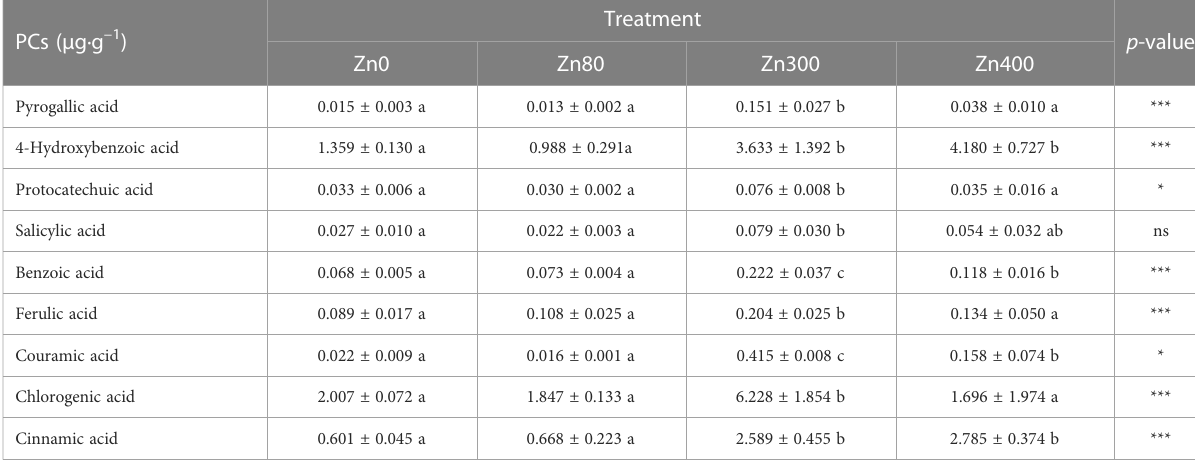
TABLE 3 Effects of ZnSO 4 treatments on phenolic compounds (PCs) in Cd-contaminated K.